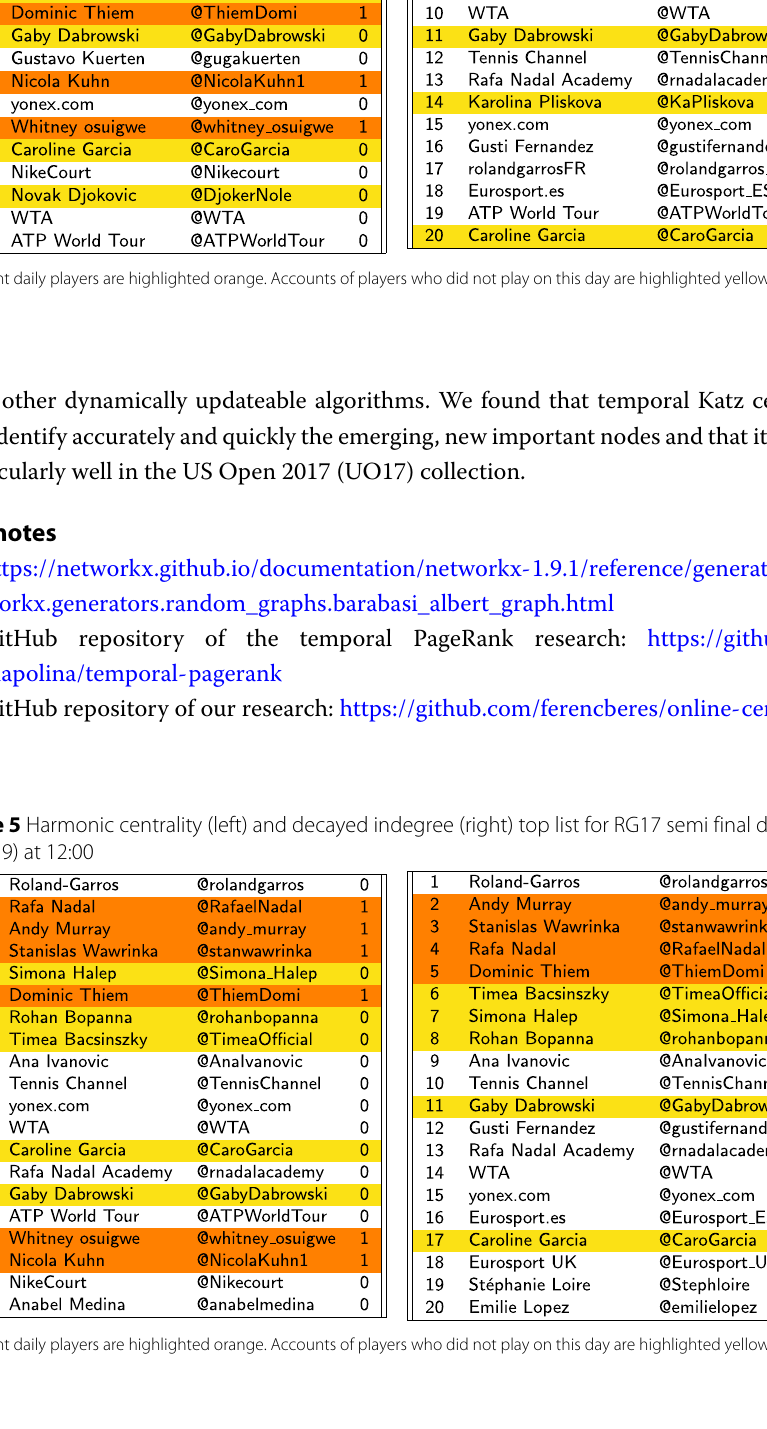
Table 4 Temporal Katz centrality with β = 1.0 (left) and β = 0.2 (right) top list for RG17 semi final day (June 9) at 12:00